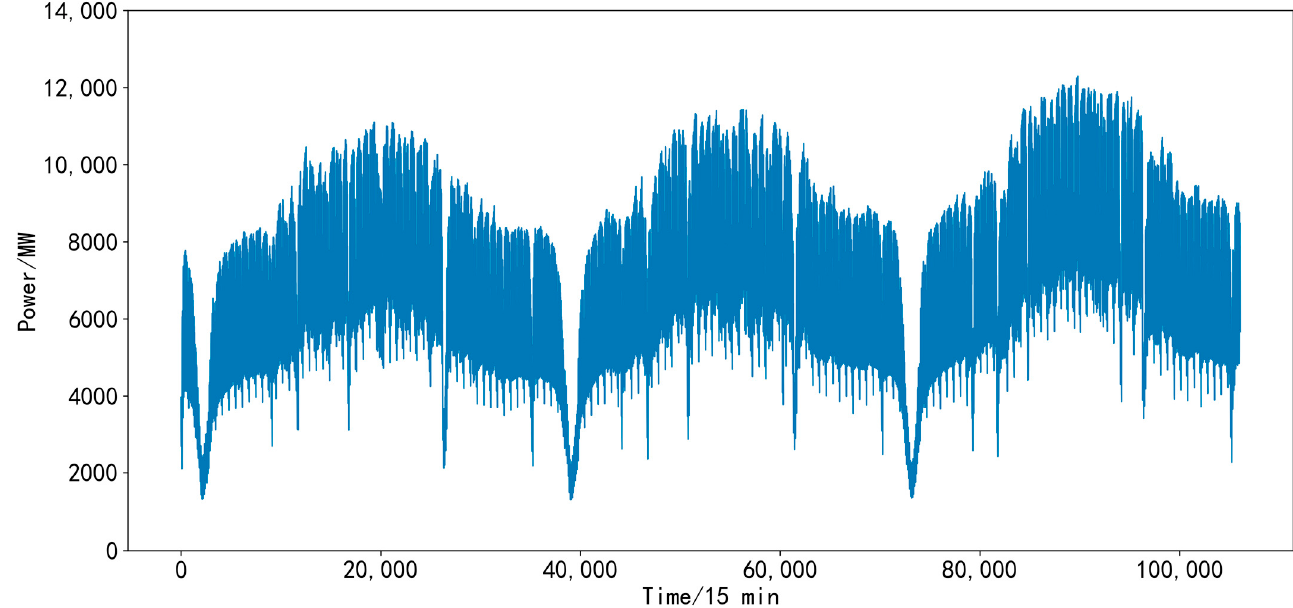
Figure 8. Annual load of Area 1.